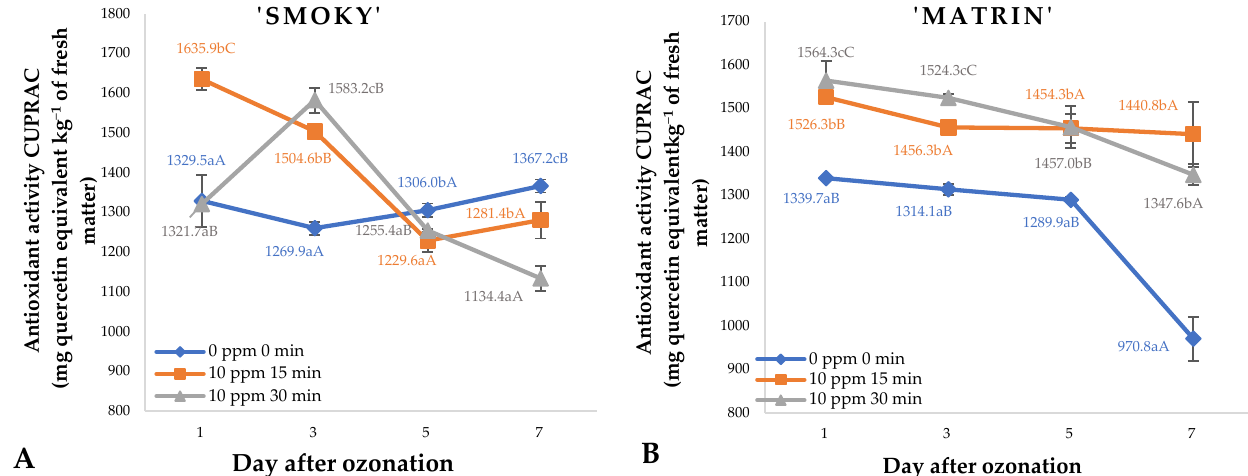
Figure 5. Antioxidant activity CUPRAC test and standard error of the means in saskatoon berries of ‘Smoky’ ( A ) and ‘Martin’ ( B ) cultivars, relative to the dose of ozone ( n = 3). Note: Differences in results between the dose of ozone on the specific days are indicated by different small letters and differences between assessment days are indicated by different capital letters. Significance level p < 0.05.